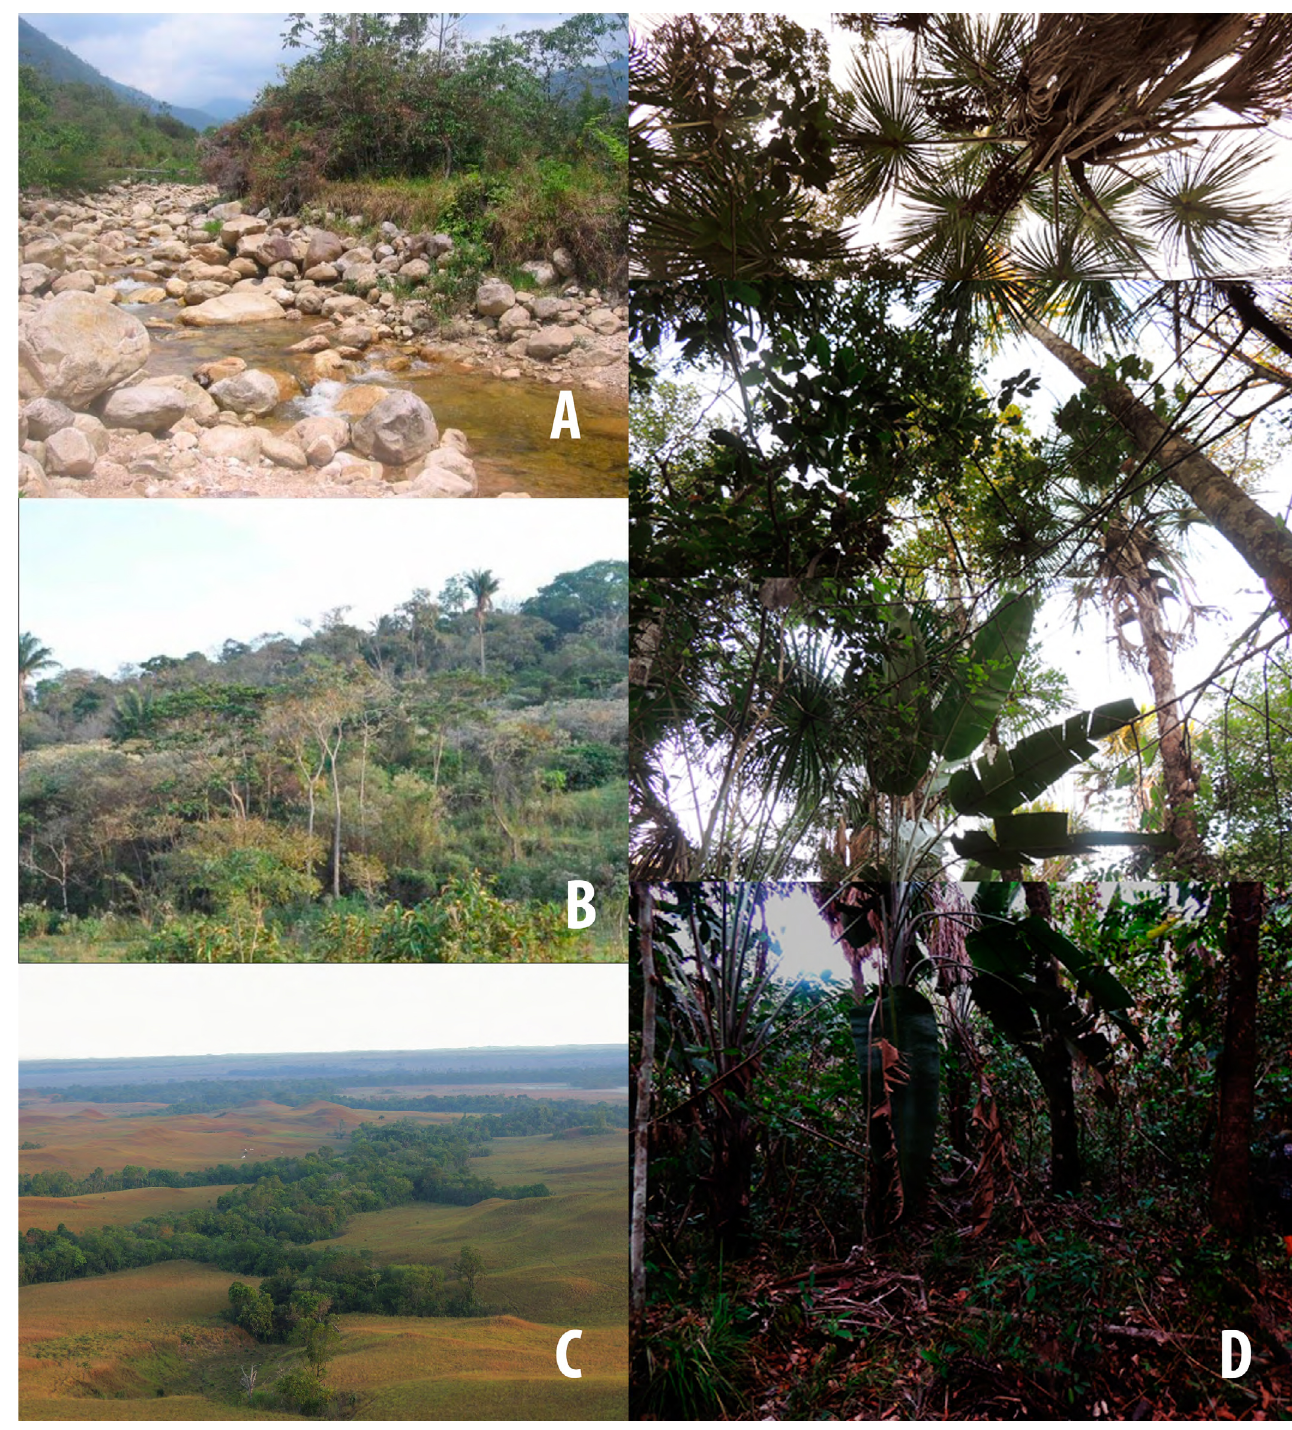
Glyphonycteris daviesi Figure 4 . Locality records of in the Orinoco region, Colombia: a) general landscape of Tame showing flooded savannahs and riparian forests; b) forest fragment in Tame; c) general landscape of San Martín showing high plains savannahs and gallery forests; and d) general physiognomy of the palm swamp in San